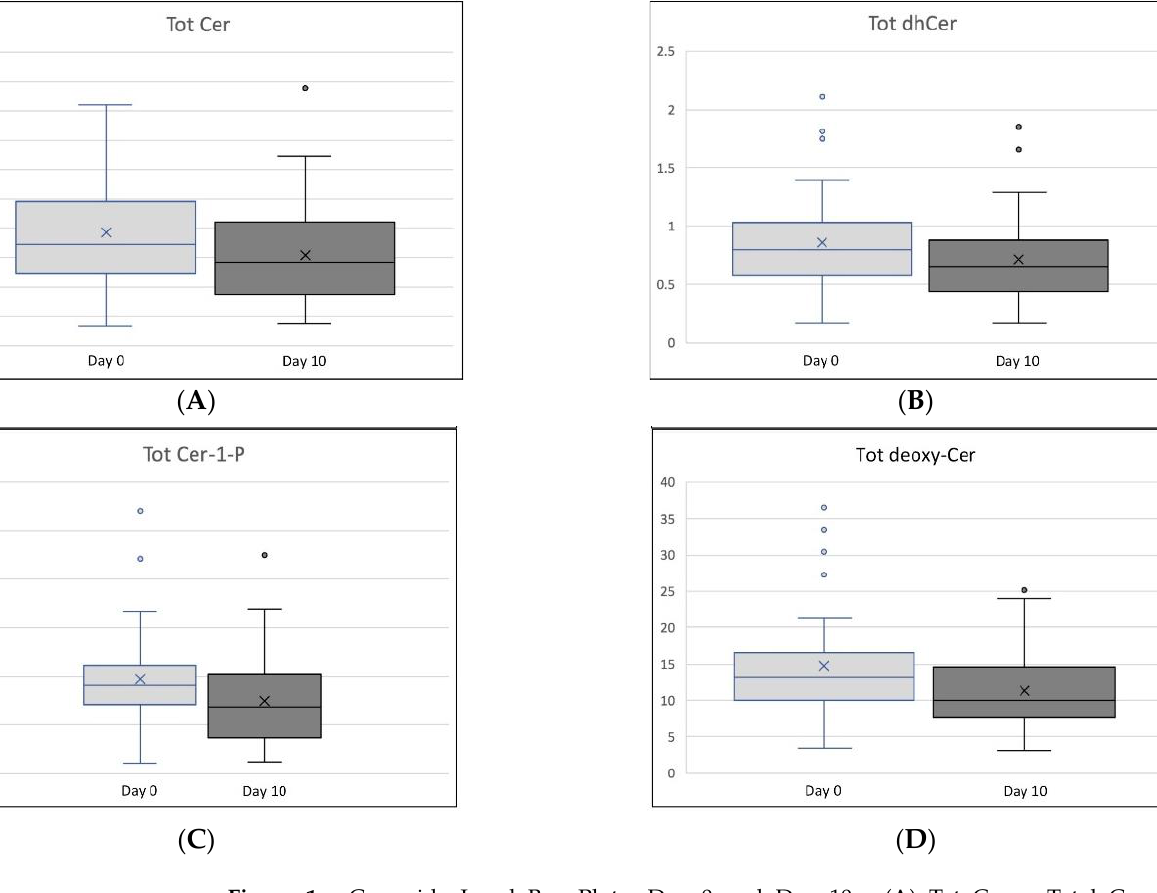
Figure 1. Ceramide Level Box Plots, Day 0 and Day 10. ( A ) Tot Cer = Total Ceramide. ( B ) Tot dhCer = Total dihydro-Ceramide. ( C ) Tot Cer-1-P = Total Ceramide-1-Phospate. ( D ) Tot deoxy-Cer = Total deoxy-Ceramide. Crosses depict means. Hollow circles show outliers.